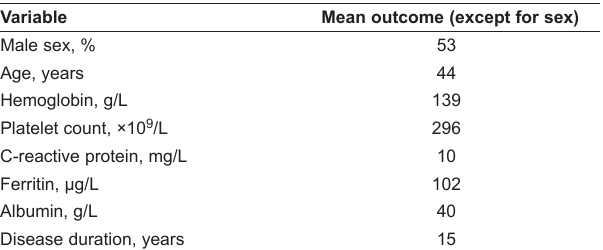
TAble 3 Ulcerative colitis